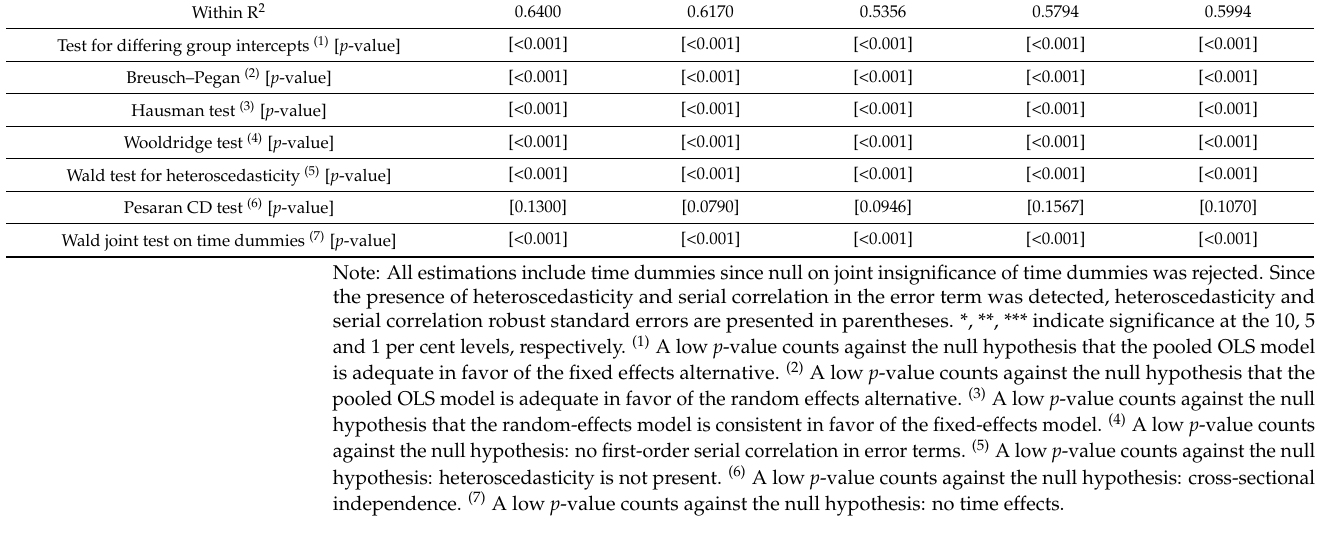
Table A2. System GMM estimates of Equation (2). Dependent variable—5-year forward-looking average growth